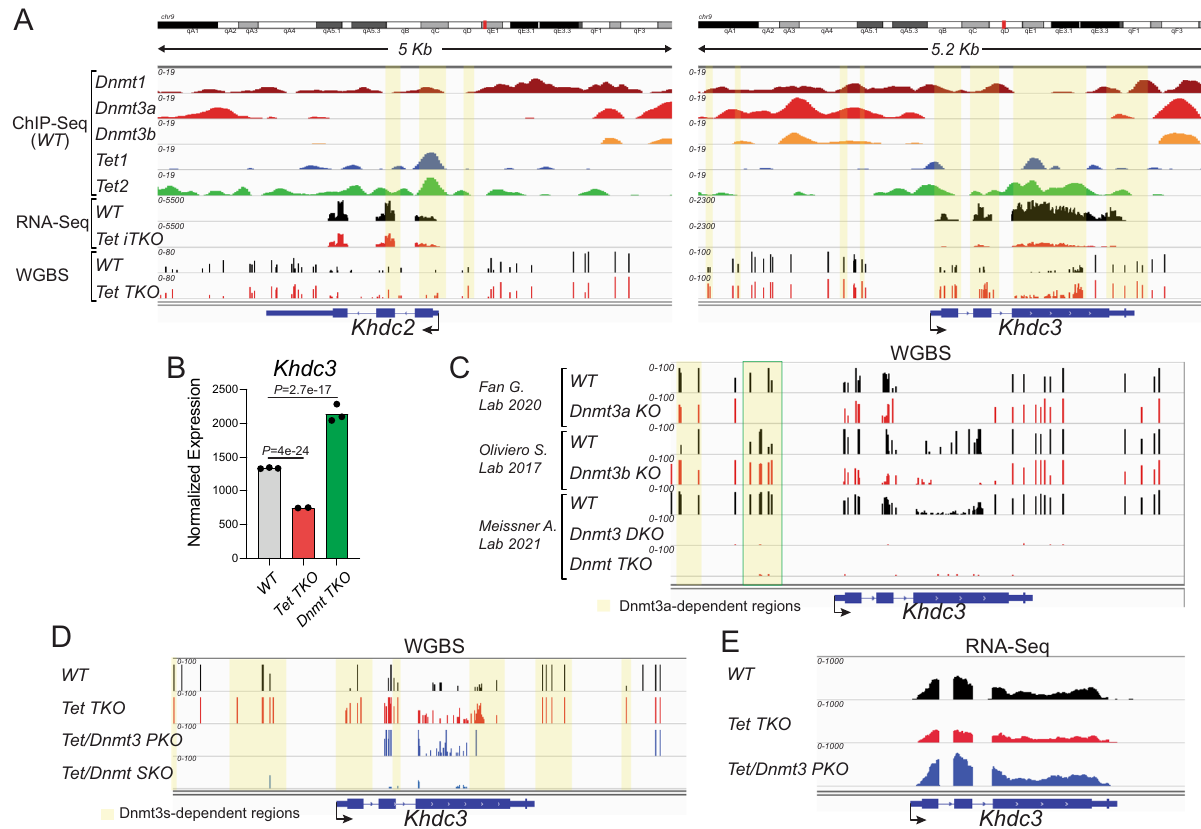
Fig. 4 | The Khdc3 promoter is controlled by TETs and DNMTs. A Genome browser view of the Khdc2 (left) and Khdc3 (right) loci in mESC. Top fi ve tracks, ChIP-SeqdataforDNMT1(darkred),DNMT3a(red),DNMT3b(orange),TET1(blue) andTET2(green) 62 – 65 .Middletwotracks, Khdc2 and Khdc3 transcriptsin Ctrl (black tracks) and Tet iTKO (red tracks) mESC generated from our Smart-Seq2 analysis. Bottom two tracks, methylation status of CpGs in the Khdc2 and Khdc3 loci, based on WGBS data 51 . Notice the increase in methylation at the promoters, gene bodies and nearby CpGs of both the Khdc2 and especially the Khdc3 genes. B Khdc3 gene expressionfromconstitutive TetTKO (red)and DnmtTKO (green)comparedto WT mESC (gray) 61 . Notice the enhanced expression of Khdc3 in mESC lacking Dnmts (green). P -adjustedvalueswerecalculatedrespectto WT mESCusingtheBenjamini- HochbergmethodtocontroltheFalse DiscoveryRate. C DNAmethylationmapsat the Khdc3 locus from single Dnmt3a - (upper group) or Dnmt3b KO (middle group)